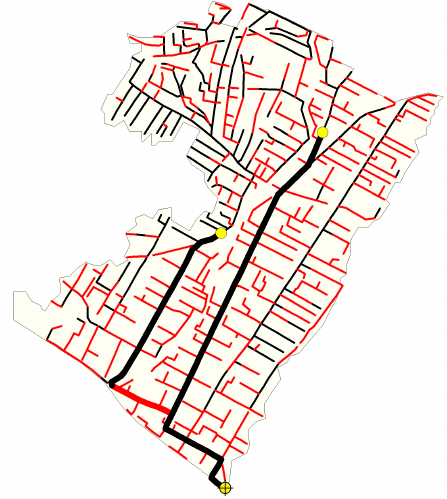
Figure 9. Exceedance of the Z ≤ 7500 threshold in the network pipes.